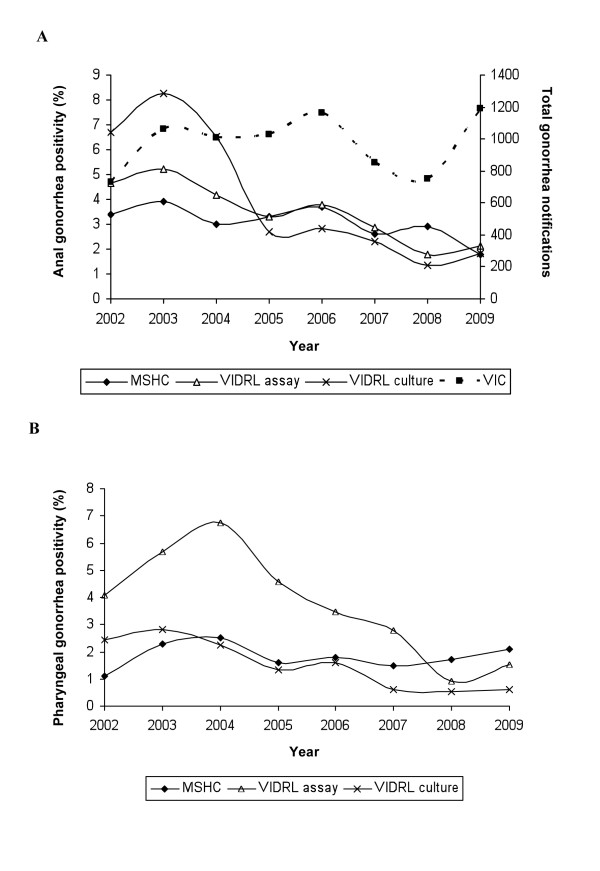
Anal and pharyngeal gonorrhea positivity. Changes in anal (A) and pharyngeal (B) gonorrhea positivity over time at both Melbourne Sexual Health Centre (MSHC) and the Victorian Infectious Disease Reference Laboratory (VIDRL; two types of sampling methods; nucleic acid amplification assay and culture). The total number of notified cases of gonorrhea in Victorian (VIC) men between 2002 and 2009 are also indicated (A). NB: For 2002 and 2009, MSHC data are only available for a 6 month time period July-Dec 2002 and Jan-June 2009.